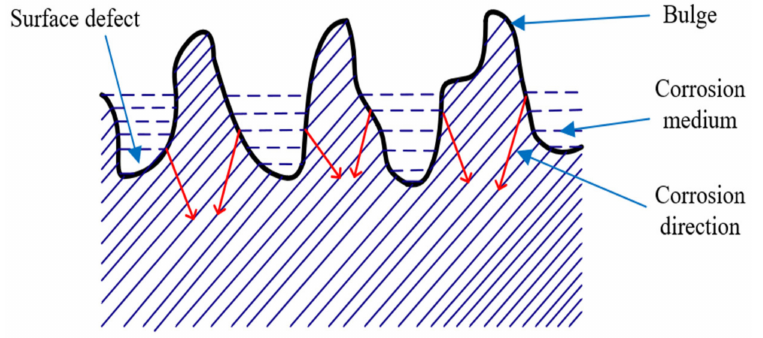
Figure 1. Schematic diagram of surface corrosion development